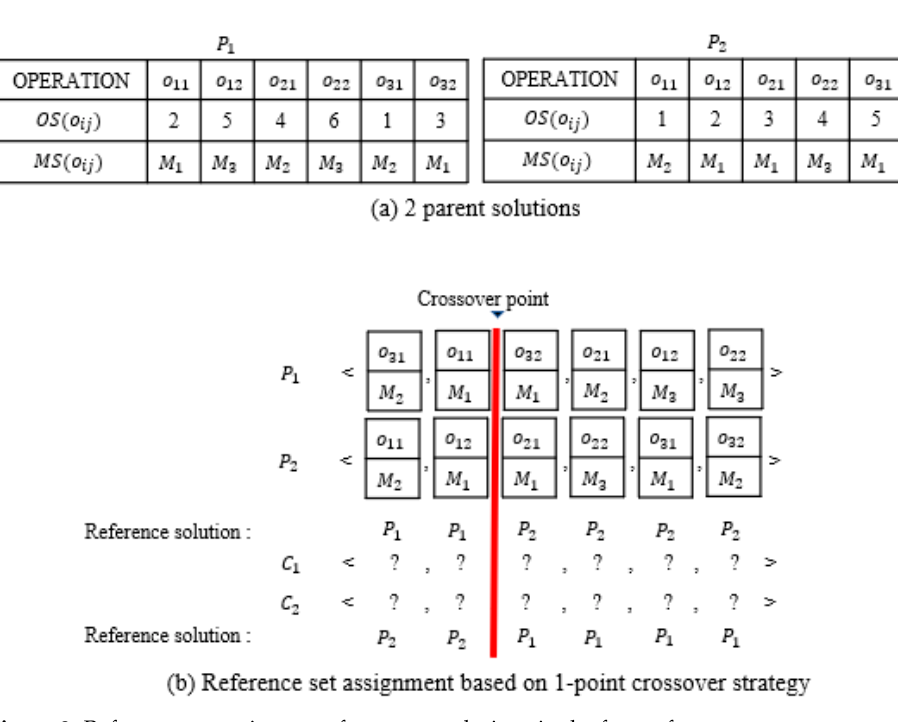
Figure 3. Reference set assignment for parent solutions in the form of a sequence.